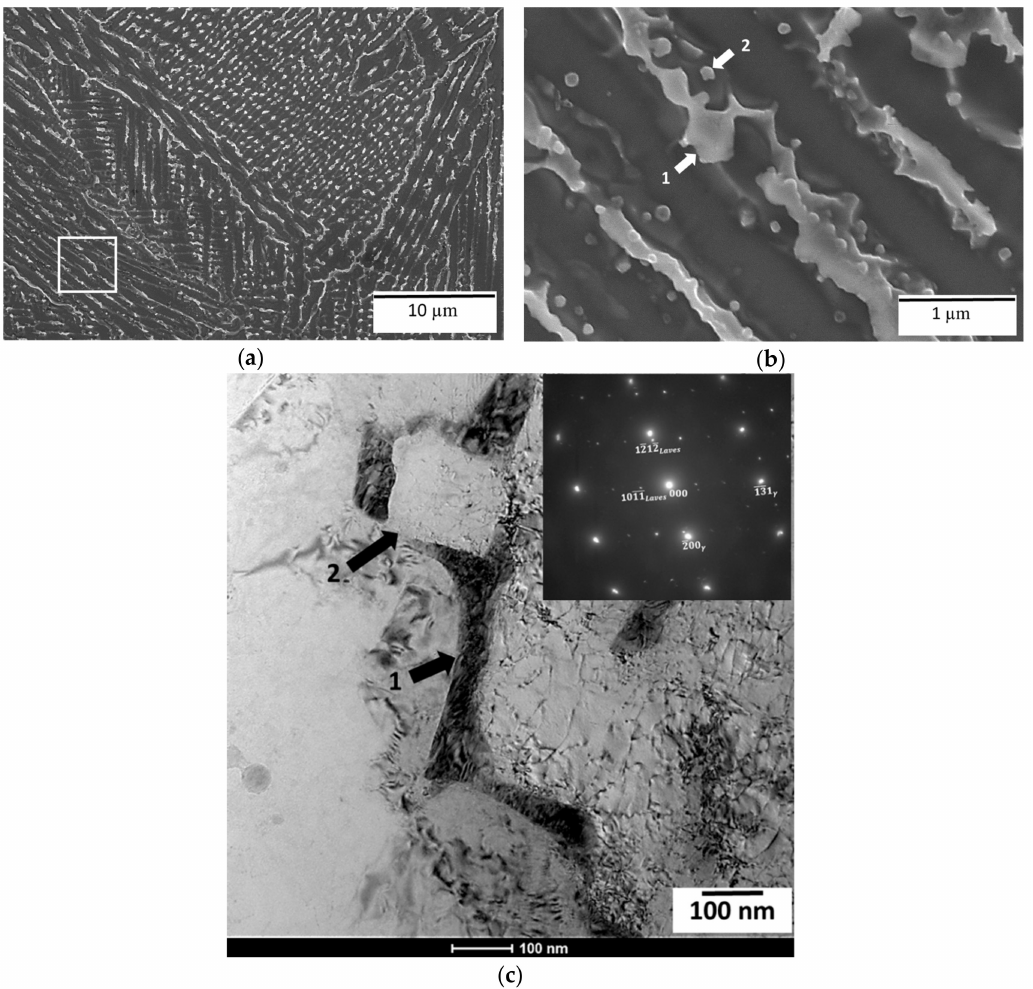
Figure 2. ( a ) Microstructure of as-built condition (electrolytically etched with phosphoric acid); ( b ) interdendritic regions in as-built condition showing (1) Laves phase and (2) MC-type carbide; and ( c ) bright field image of (1) Laves phase and (2) NbC carbide. The inset shows the di ff raction pattern of Laves phase in γ -matrix.